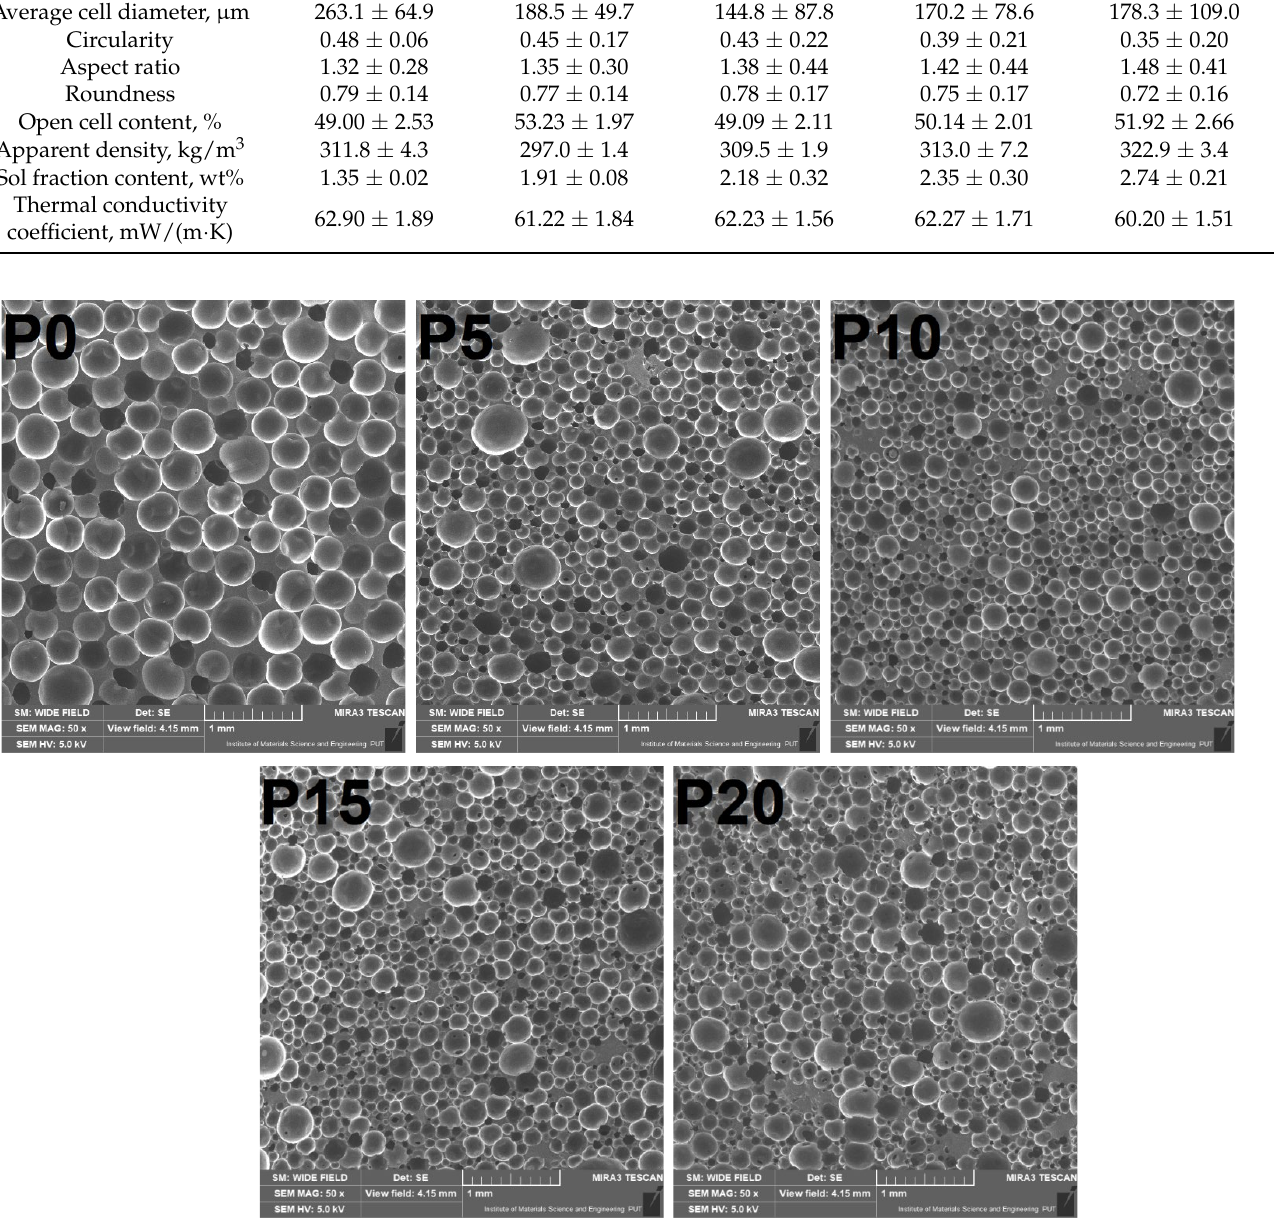
Figure 4. Images showing the cellular structure of prepared samples obtained with scanning electron microscopy.